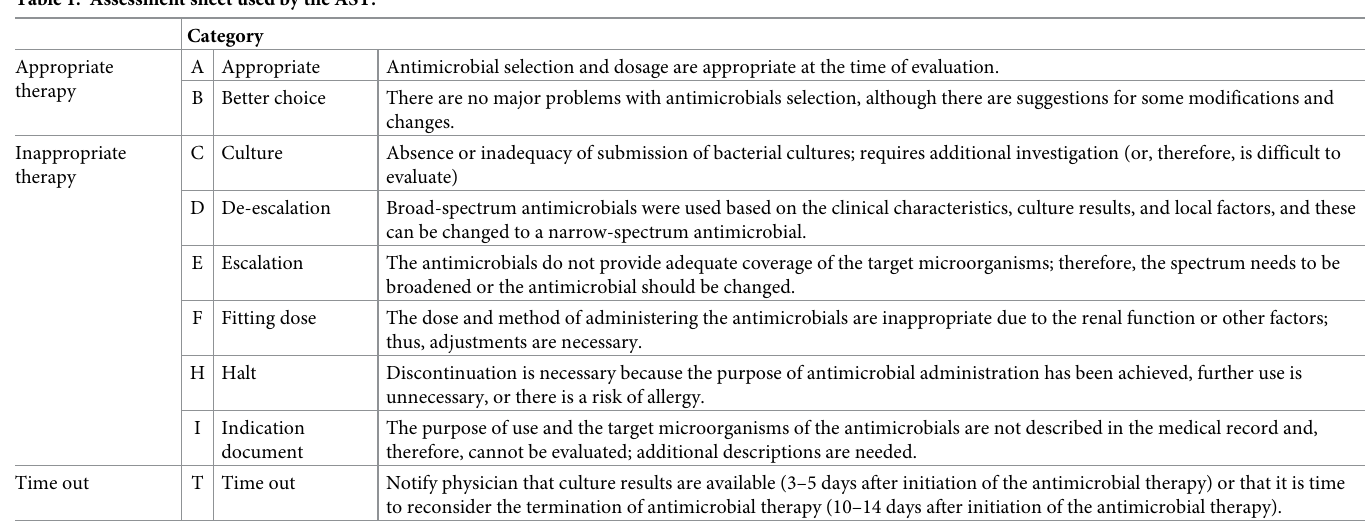
Table 1. Assessment sheet used by the